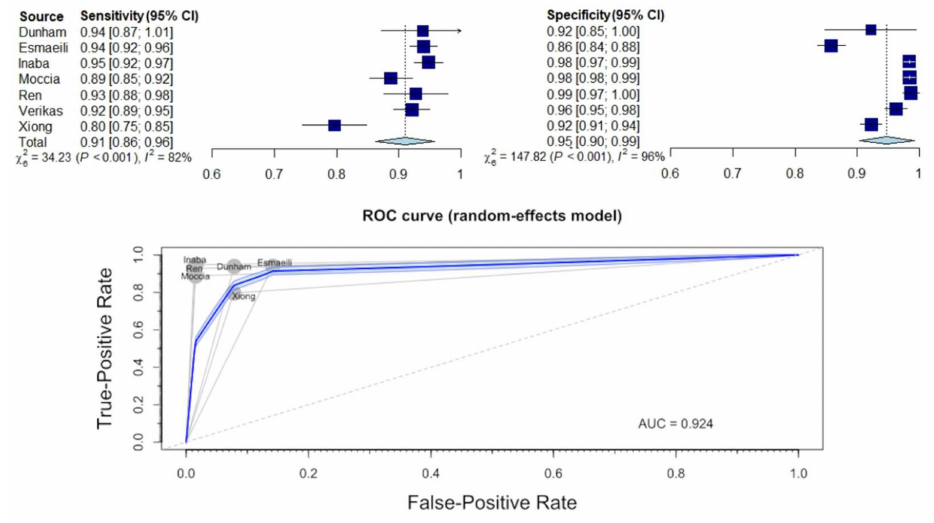
Figure 5. Forest plot and ROC curve illustrating the diagnostic performance of AI distinguishing benign and malignant laryngeal